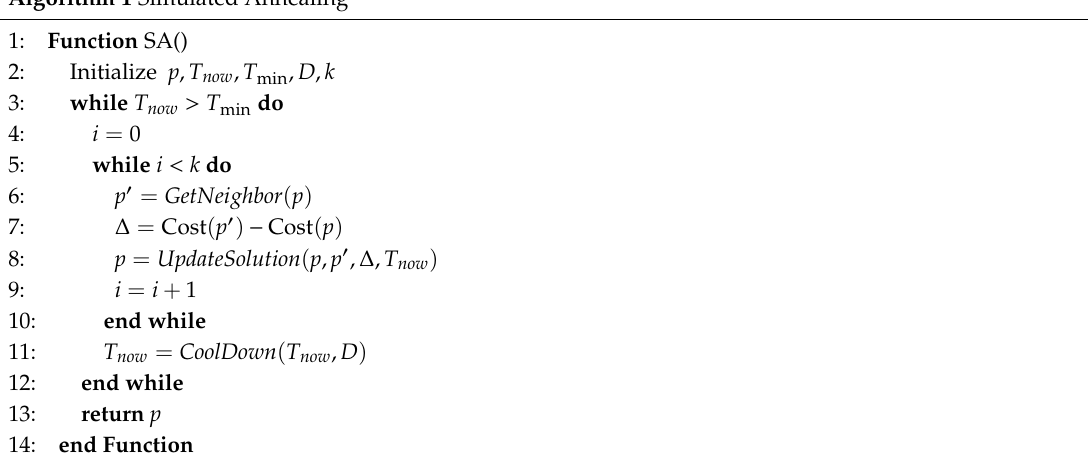
Algorithm 1 Simulated